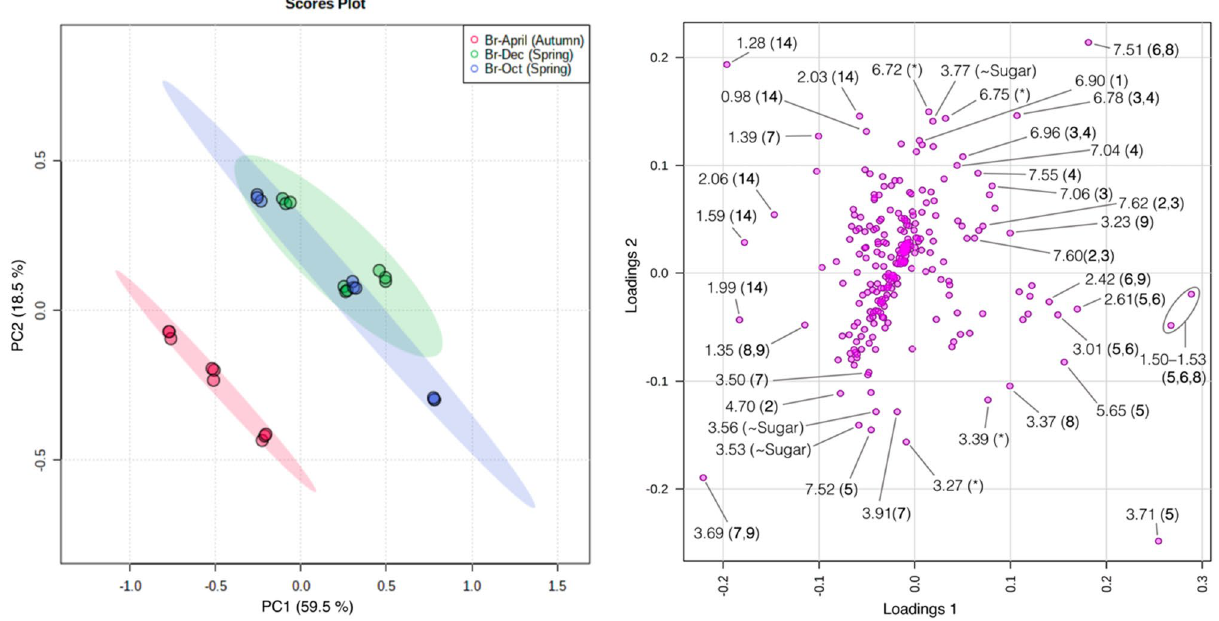
Figure 4. PCA over the 1 H HR-MAS NMR fingerprints representing seasonal influence for major metabolites. NMR data were processed in TopSpin v3.6.3 software package and preprocessed in analysis of mixture (AMIX) v3.9.12 software package (Bruker BioSpin: https:// www. bruker. com), PCA analysis was performed in